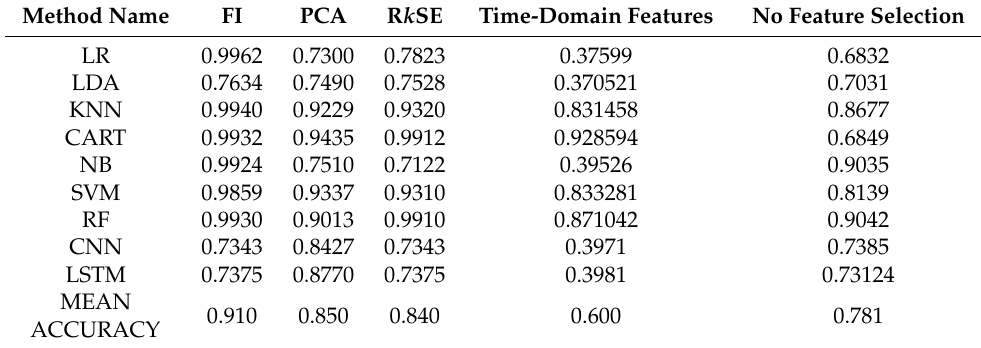
Table 6. Component Fault Diagnosis Using Various Feature Engineering and Classification